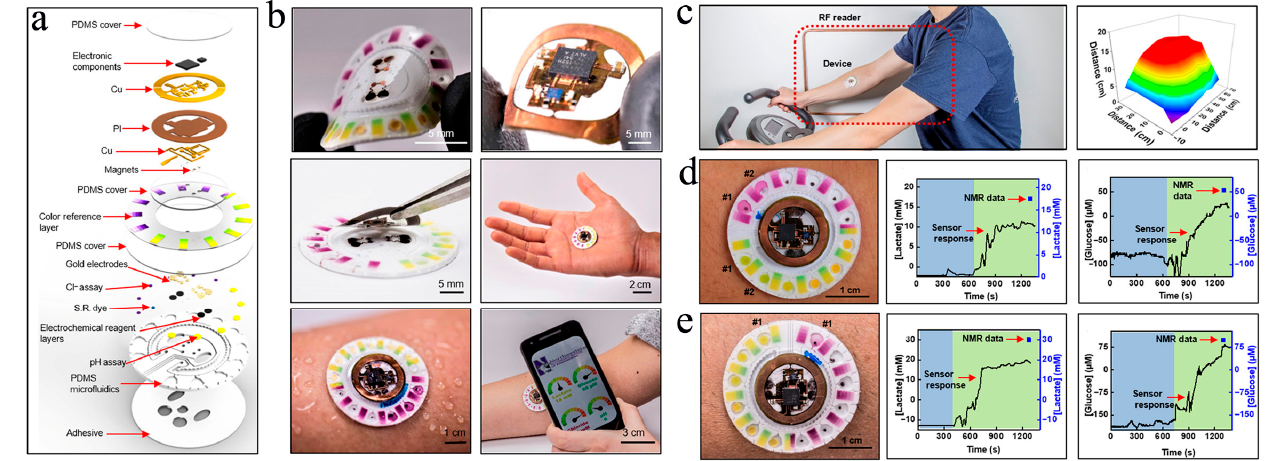
Figure 4. Schematic diagram of the components (a) and the structure (b) of this wearable and wireless μ -EBFC-SPB. PI: polyimide; S.R.: sweat rate. ( c ) The performance test of this wearable and wireless μ -EBFC-SPB on human skin, and its capacity in monitoring glucose (d) and lactic acid (e) in sweat on the human skin surface [59].